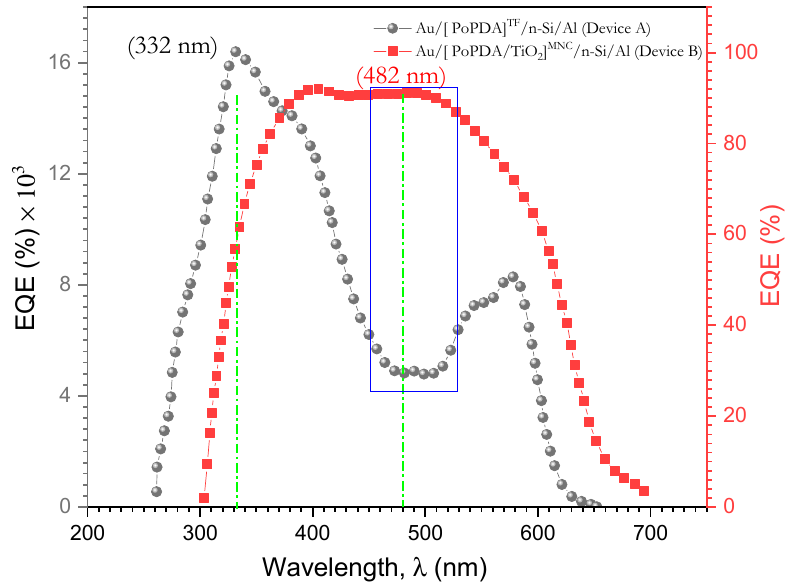
Figure 17. EQE spectra of the PPDs for devices Au/[PoPDA] TF /p-Si/Al ( A ) and nanocomposite Au/[PoPDA/TiO 2 ] MNC /p-Si/Al ( B ).